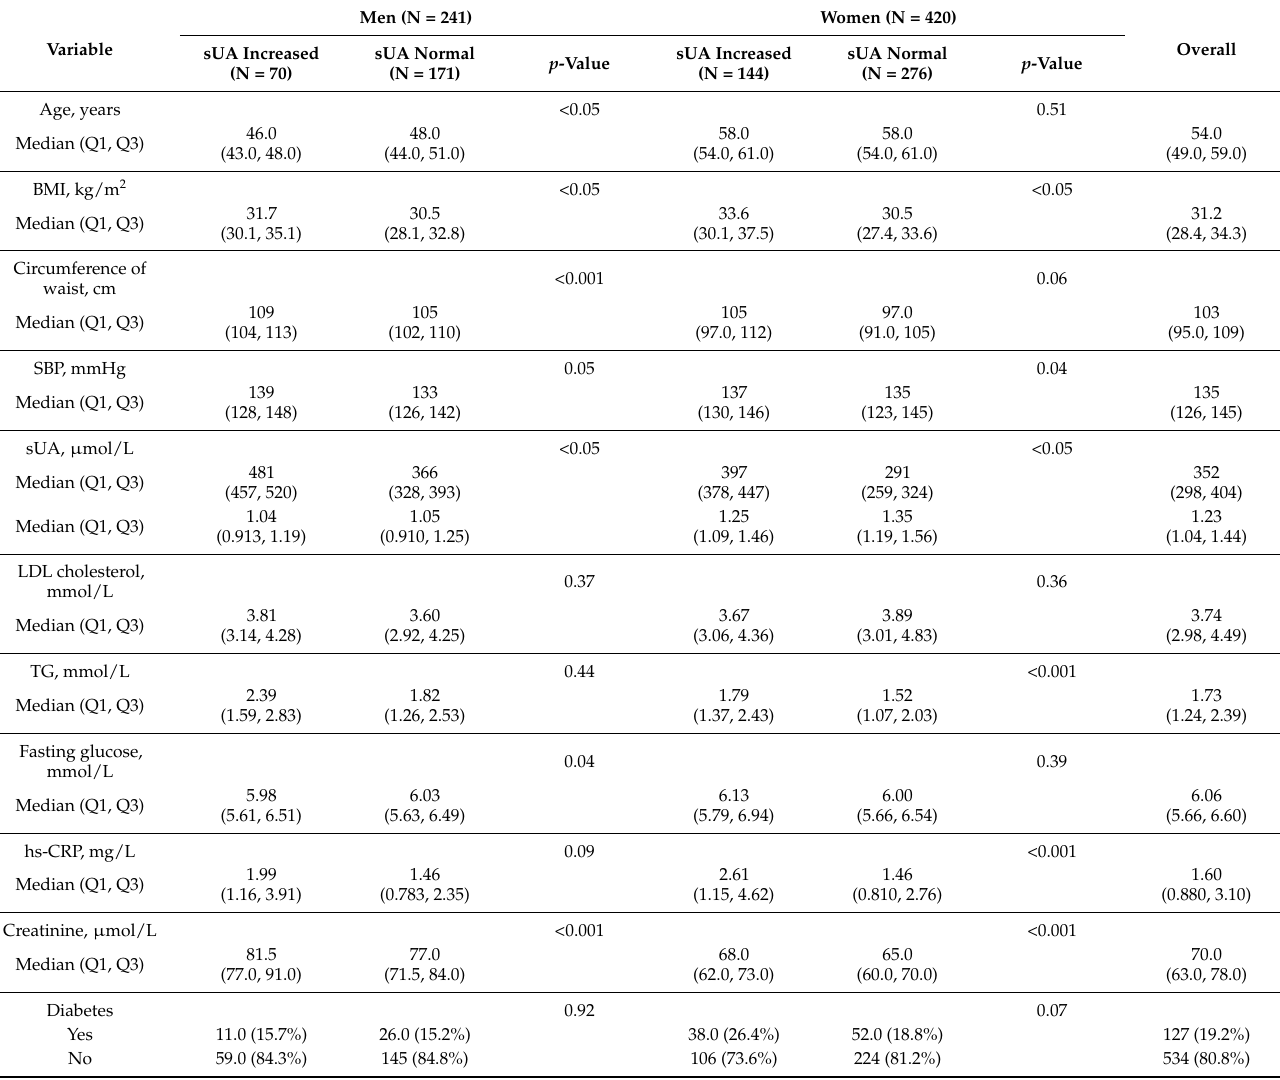
Table 1. Main clinical characteristics of